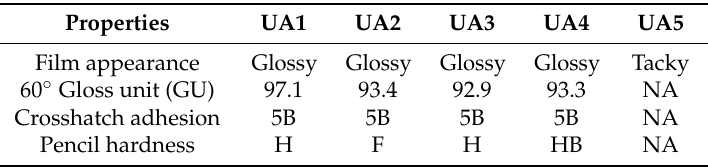
Table 7. The initial cured film properties.